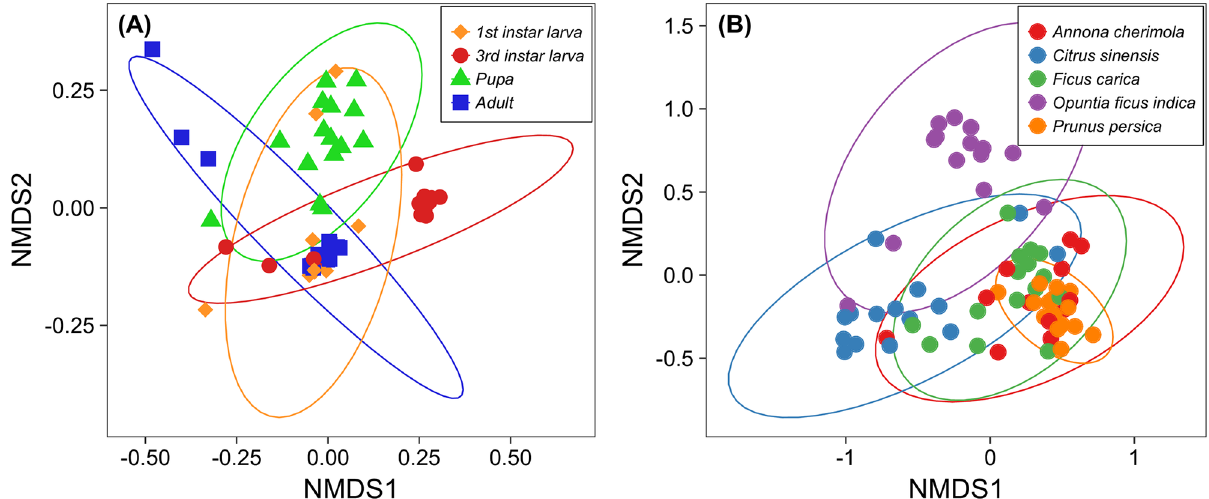
Fig 1. NMDS (Non-metric Multidimensional Scaling) analysis of microbial communities. (A) different life stages of C . capitata (stress 0.09); (B) larvae of C . capitata feeding on different host plants (stress 0.16). Ellipses are calculated at the 95% confidence interval.